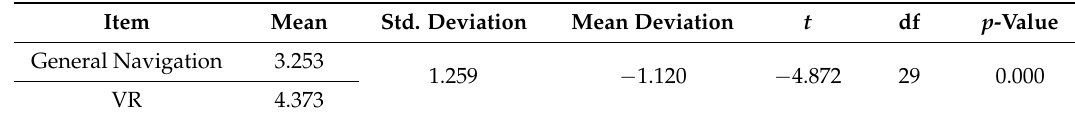
Table 4. Hypothesis test of users’ attitude.